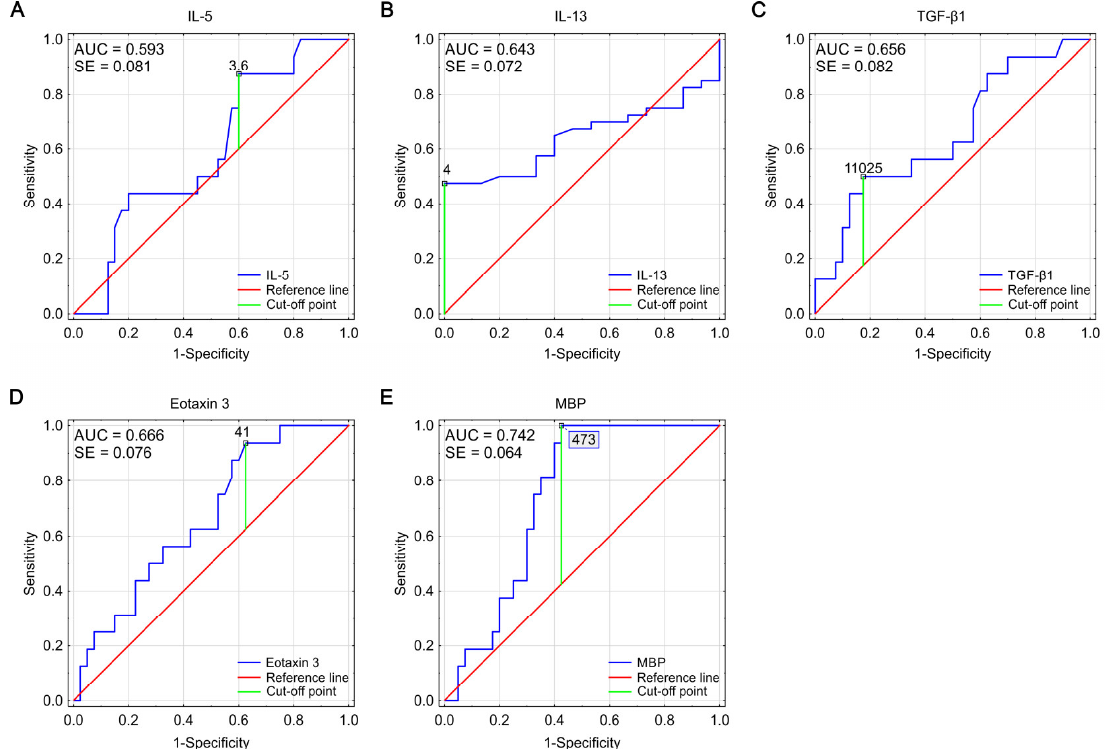
Figure 3. ROC curves for IL-5 ( A ), IL-13 ( B ), TGF- β 1 ( C ), eotaxin 3 ( D ), and MBP ( E ), showing their effectiveness as markers predicting the diagnosis of EoE. Optimal cut-off points were determined using Youden index analysis (AUC—area under the curve, SE—standard error).